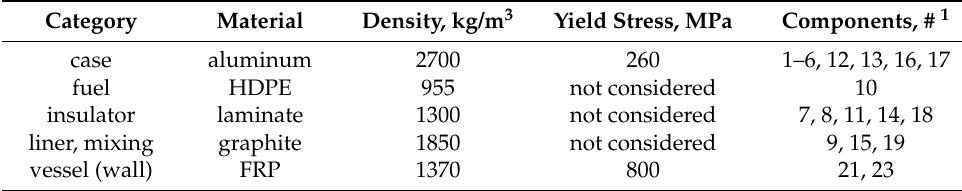
Figure 6. Component breakdown and depictions of thrust chamber and pressure vessel. Table 2. Summary of material